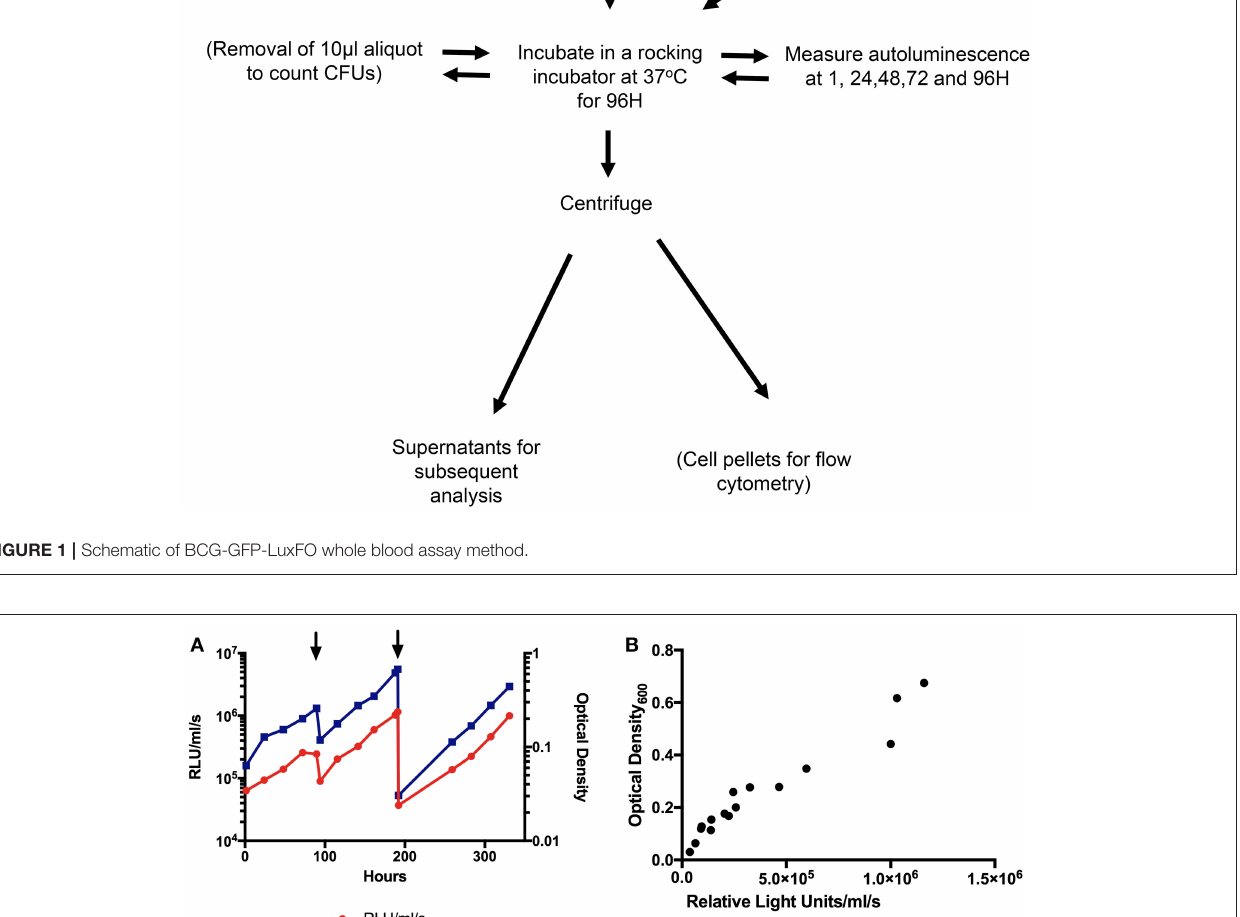
Frontiers in Pediatrics |